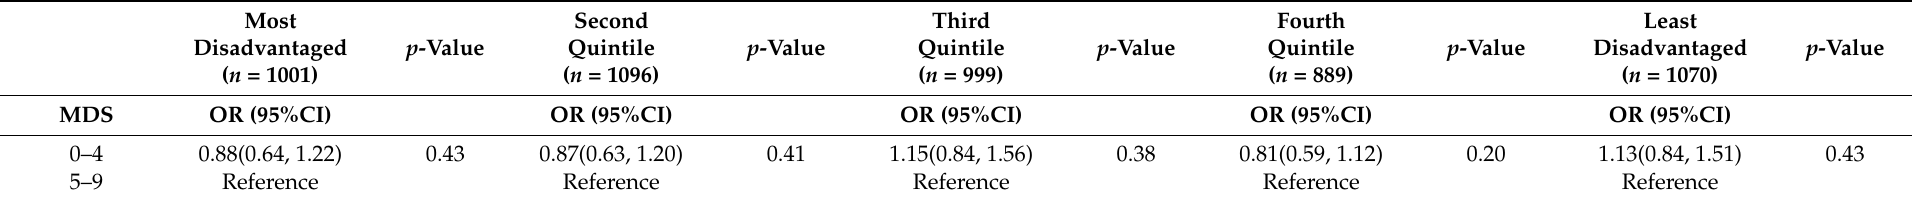
Table 4. Multivariable adjusted associations between low adherence MDS (scores 0–4 vs. 5–9) and weight related complications (EOSS 2–4 vs. 0–1) by SEIFA strata in the AHS 2011 to 2012 ( n =